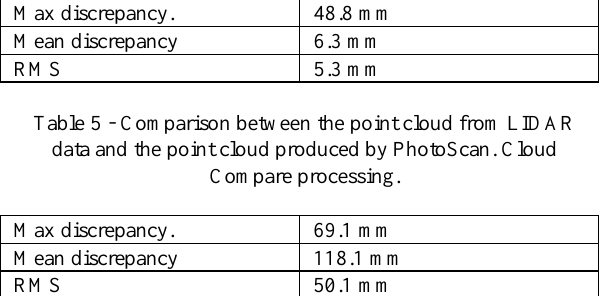
Table 6 - Comparison between the point cloud from LIDAR data and the point cloud produced by MicMac. Cloud Compare processing.